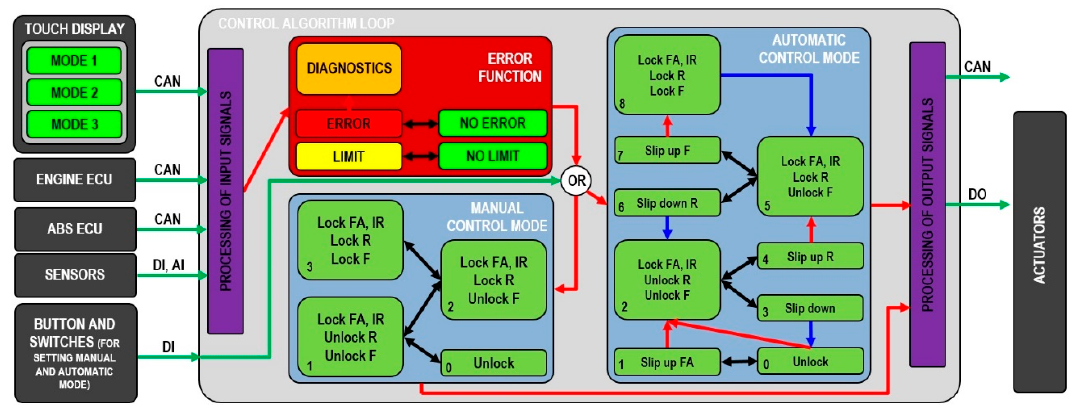
Figure 3. Diagram of the control algorithm (DI—Digital inputs, AI—Analog inputs, DO—Digital